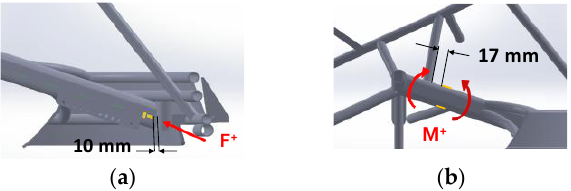
Figure 1. ( a ) OffCarr. Go Try; ( b ) Frame principal tubes: 1: Side Tube; 2: Seat Tube; 3: Front Tube; 4: Main Tube; 5: Back Tube; 6: Axle Tube.